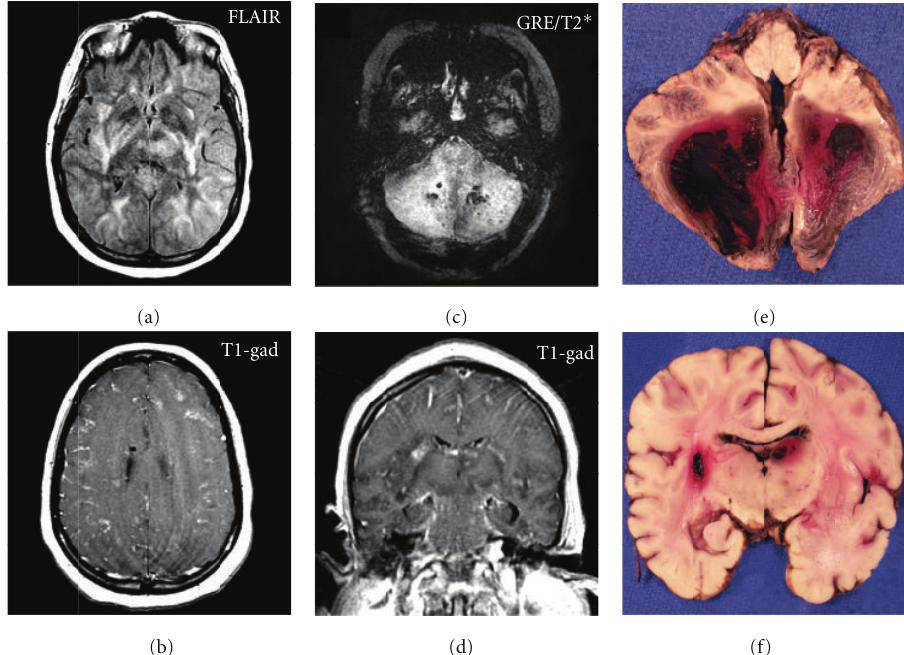
Figure 1: (a) FLAIR MRI sequence demonstrates widespread abnormal signal in the subcortical white matter, internal capsule, putamen, globus pallidus, and thalamus bilaterally. (b) T1 post-gadolinium axial MRI sequence demonstrates di ff use leptomeningeal enhancement over the convexities bilaterally and foci of parenchymal enhancement within the cortex bilaterally. (c) Gradient echo (GRE/T2 ∗ ) MRI sequence demonstrates hemorrhage in the deep cerebellar white matter bilaterally (mottled black signal, representing magnetic susceptibility). (d) T1 post-gadolinium coronal MRI sequence demonstrates basal leptomeningeal enhancement surrounding the brainstem. (e) Postmortem axial section through the brainstem and cerebellum demonstrates severe bilateral hemorrhage and necrosis of the cerebellar hemispheres. (f) Postmortem coronal section demonstrates widespread but patchy areas of hemorrhage and necrosis in the deep gray nuclei bilaterally and the cerebral hemispheres